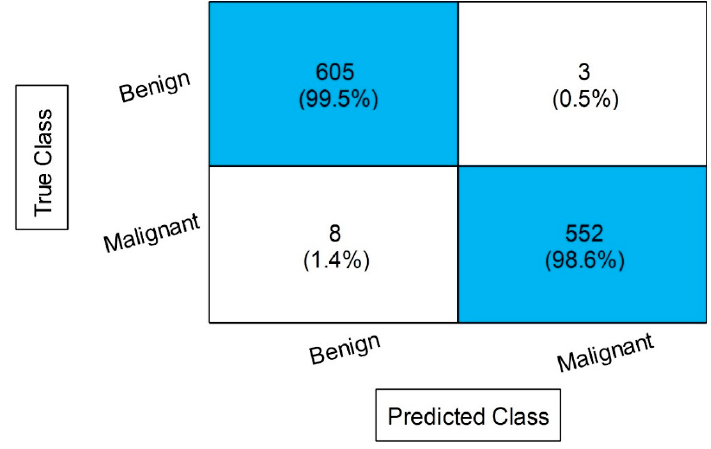
Figure 13. Confusion matrix of CSVM after employing the proposed feature selection.